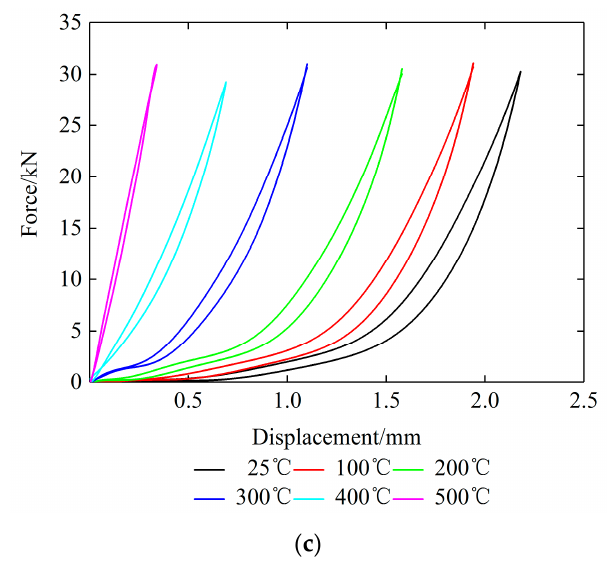
Figure 7. Force–displacement curves of each specimen under different temperatures: ( a ) Specimen 1; ( b ) Specimen 2; ( c ) Specimen 3.